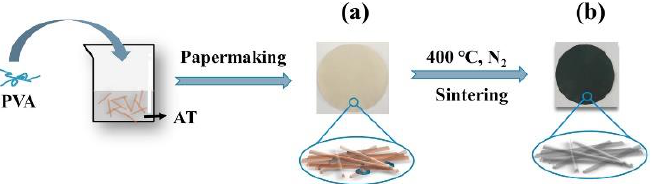
Figure 14. Schematic illustration of the preparation process for AT-based NFMs. ( a ) Unsintered AT-based NFMs, ( b ) Sintered AT-based NFMs. Reprinted from Ceramics International, Volume 43, Yekai Zhu, Dajun Chen, Novel clay-based nanofibrous membranes for effective oil/water emulsion separation, Pages No. 9465, Copyright (2017), with permission from Elsevier [119].